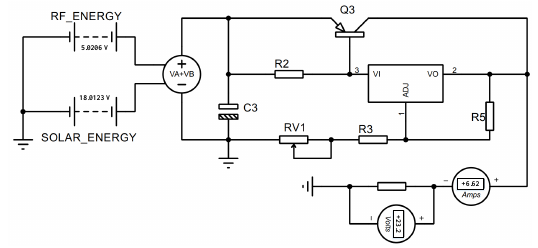
Figure 6. The stabilizer voltage and boost current system